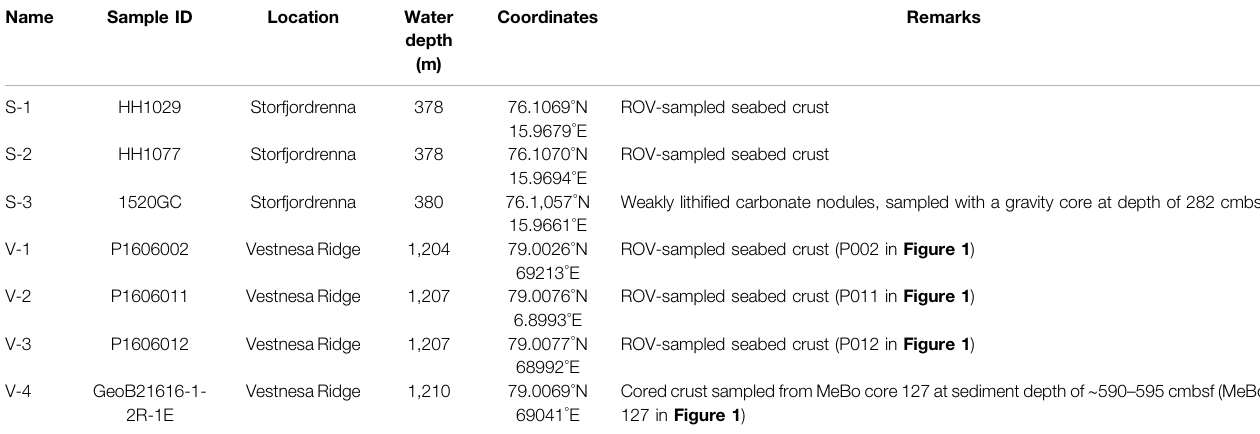
TABLE 1 | List of studied seep carbonates, sample locations, and remarks describing the samples and where they were collected.